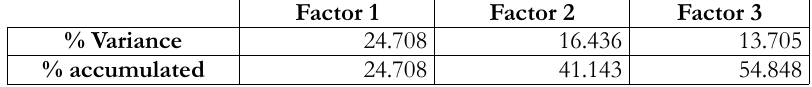
Table 1. Variance explained according factors